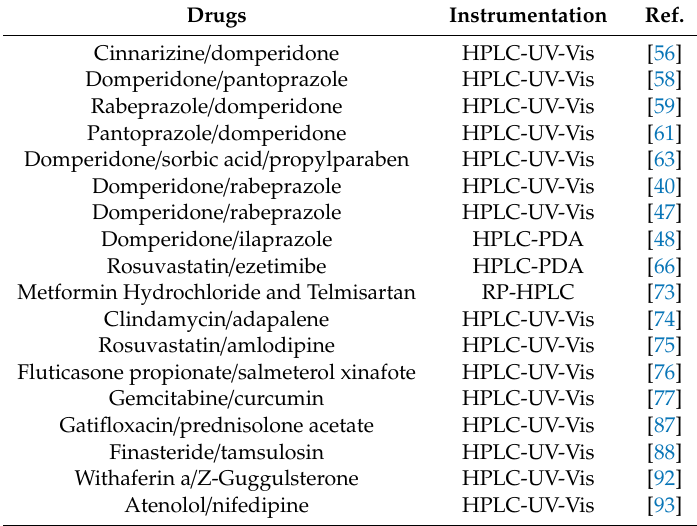
Table 3. HPLC procedures developed and validated for binary drug-association co-formulation analyses in mixtures or other